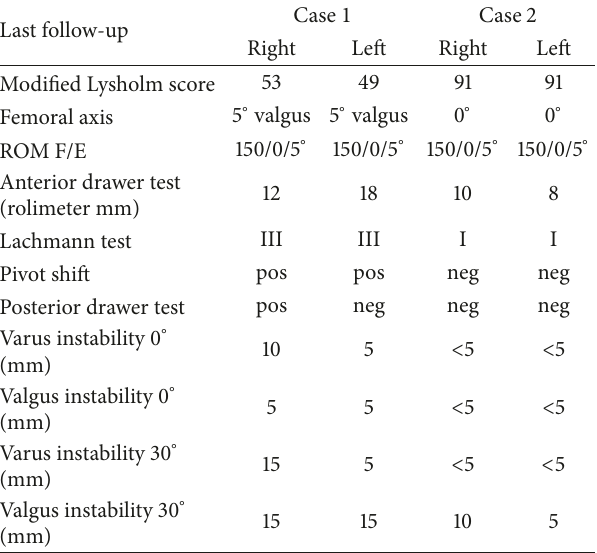
Table 1: Bilateral clinical outcomes of both patients at their last